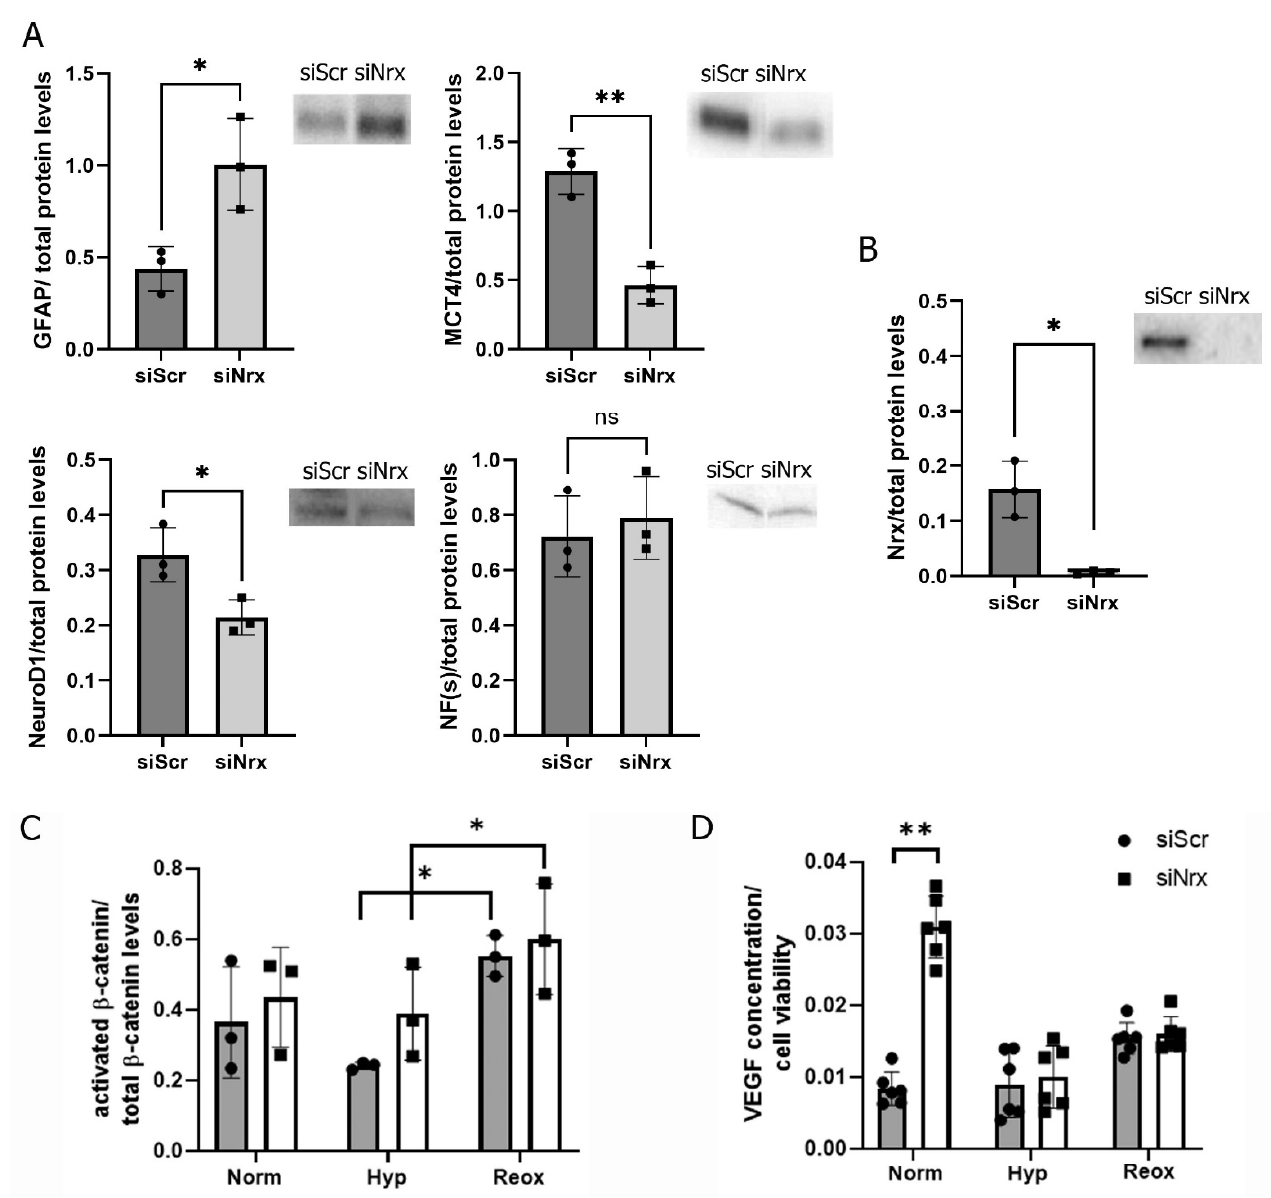
Figure 3. Protein levels in ARPE-19 cells. ( A ). Western blot analysis of differentiation markers: GFAP ( p = 0.0239; n = 3), MCT4 ( p = 0.0027; n = 3), NeuroD1 ( p = 0.0281; n = 3) and NF(s) in siScr and ( B ) . siNrx ARPE-19 cells. C. Nrx protein levels analyzed using Western blot ( p = 0.0361; n = 3). ( C ). Western blot analysis of activated β -catenin over total β -catenin levels in siScr and siNrx ARPE-19 cells exposed to H-I and reoxygenation (siScr: p = 0.0272; n = 3, siNrx: p = 0.0133; n = 3). ( D ). ELISA assay for VEGF levels in siScr and siNrx ARPE-19 cells ( p = 0.0063; n = 6). *, ** Asterisks represent different levels of